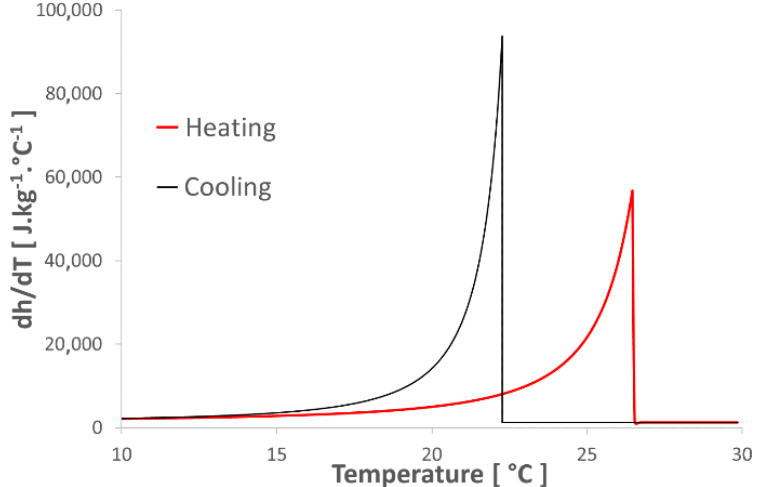
Figure 6. Evolution of the derivate of enthalpy as a function of time.